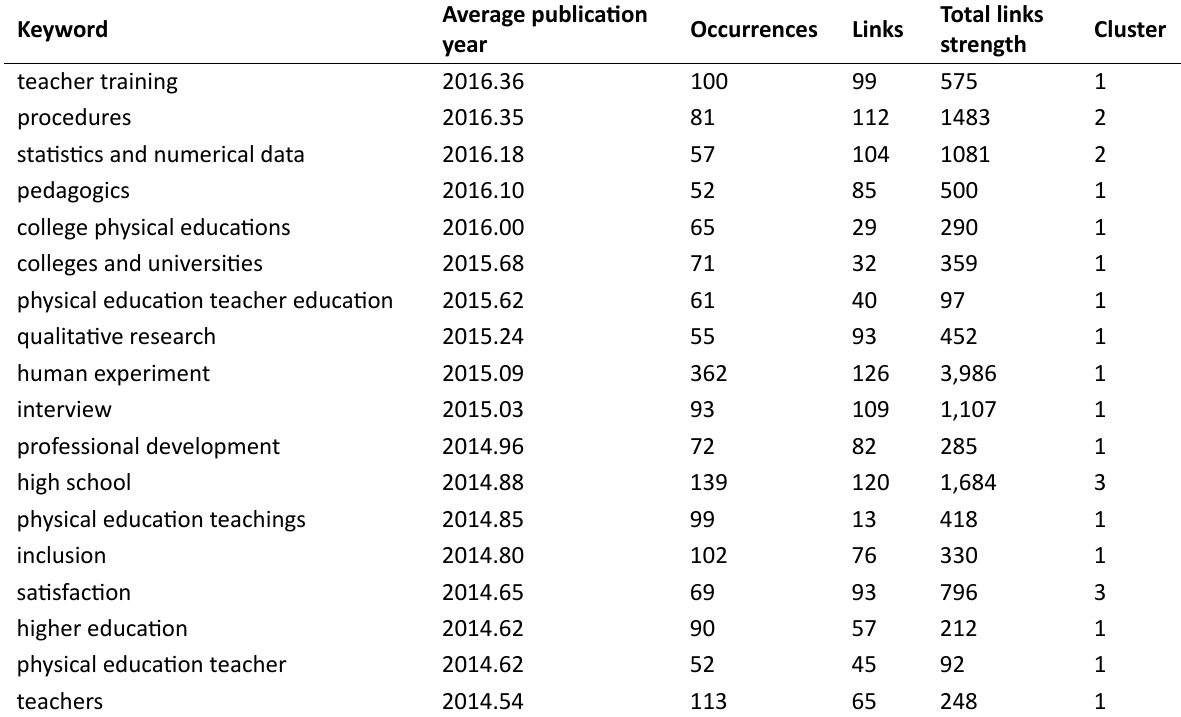
Table 5. Bibliometric characteristics of the most up-to-date keywords in the physical education research field (sorted by date of